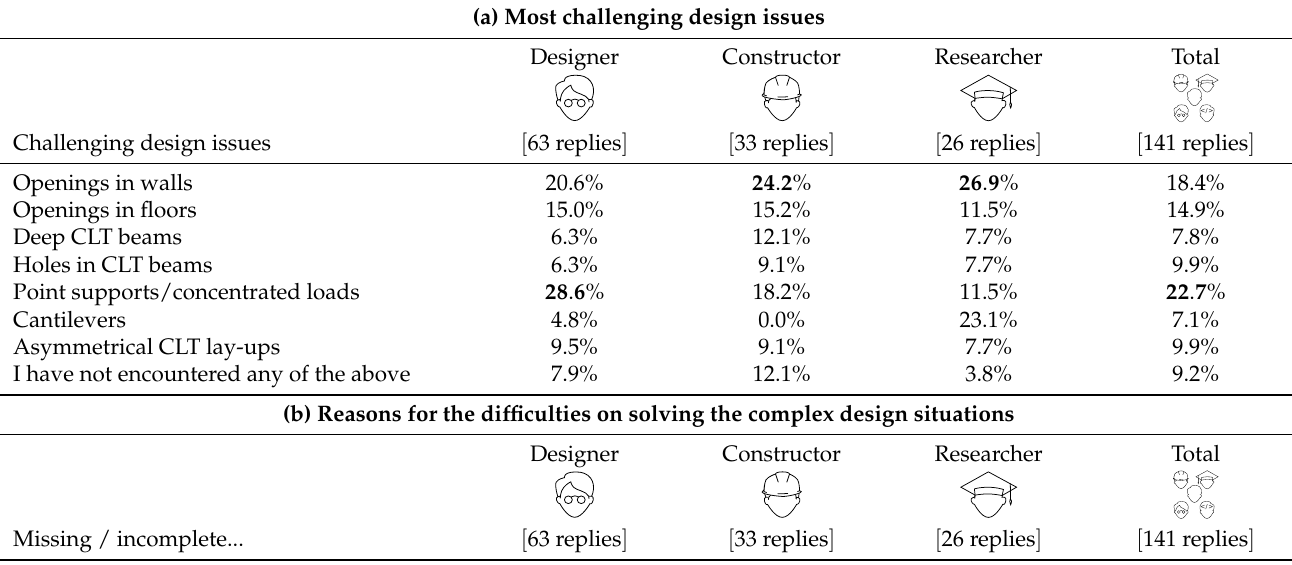
Table 7. Design issues (single